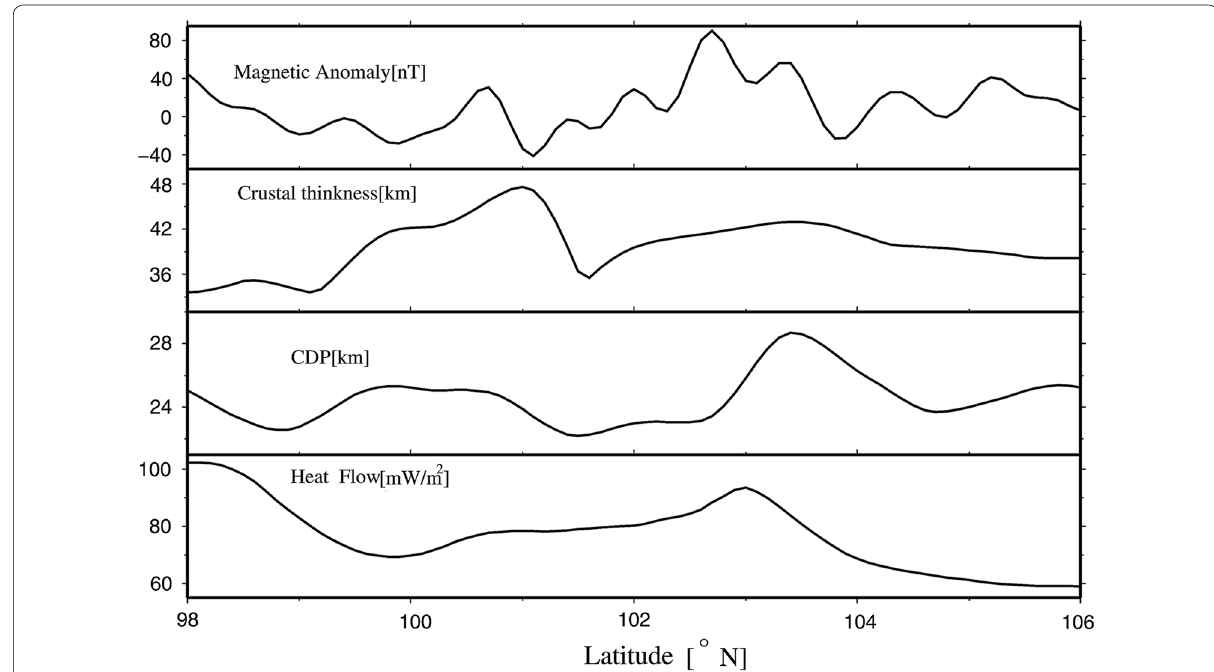
Fig. 9 Magnetic anomaly, crustal thickness, depth of the Curie surface, and terrestrial heat flow on the cross section at 25°